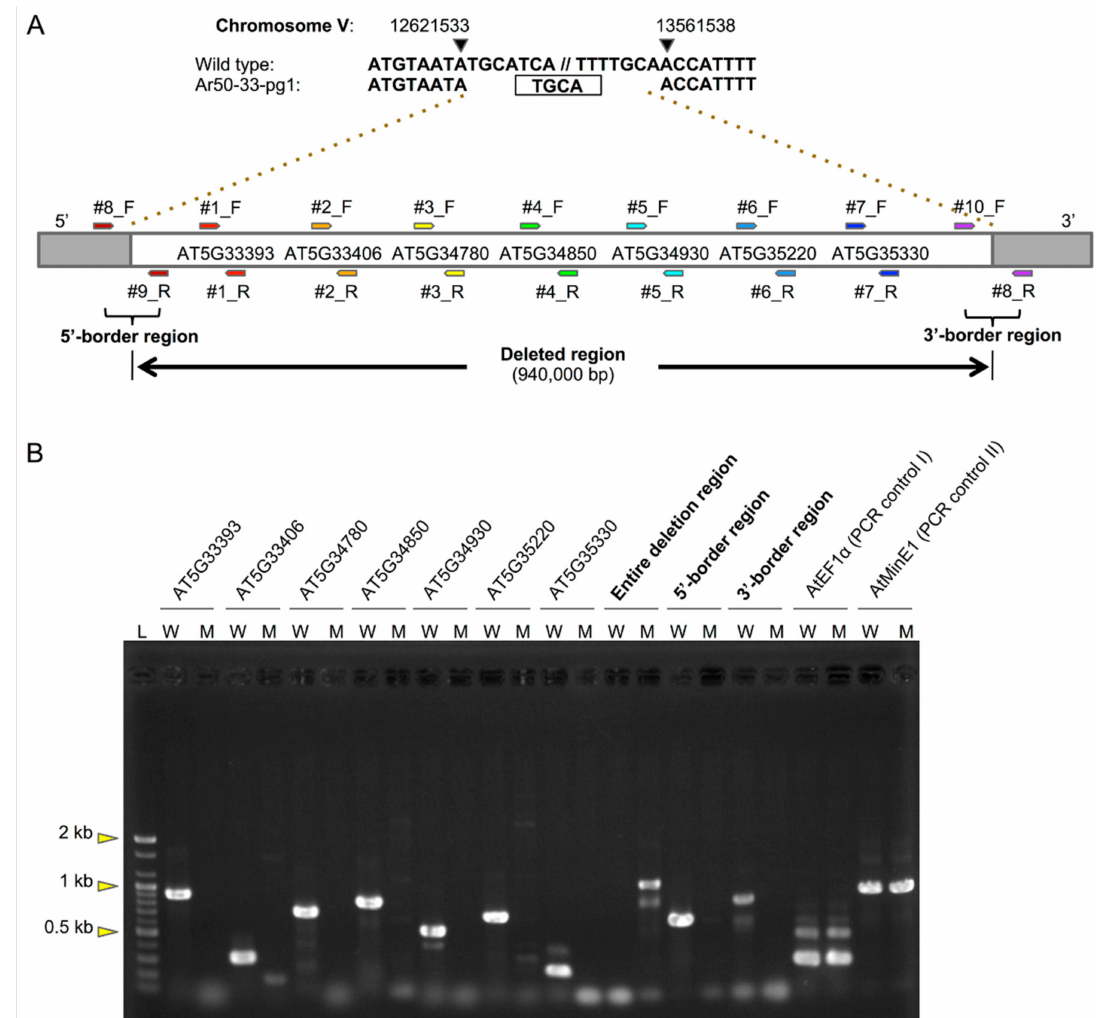
Figure 5. Large chromosomal deletion in Ar50-33-pg1 and genomic PCR analysis. ( A ) Schematic diagram of the deleted region on Ar50-33-pg1 chromosome V. Box denotes a microhomology sequence. Relative positions of genes and PCR primers are indicated. ( B ) Agarose gel electrophoresis of PCR products. L: DNA ladder marker, W: wild type, M: Ar50-33-pg1. Full details of deleted genes, PCR primers, and PCR products are in Table 2, Tables S1 and